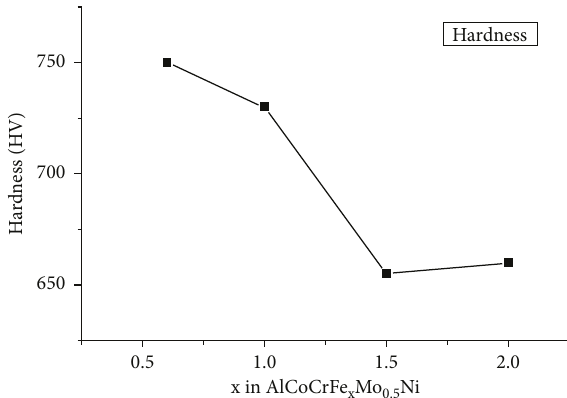
Figure 17: Vickers hardness of AlCoCrFexMo respect to Fe content [32].